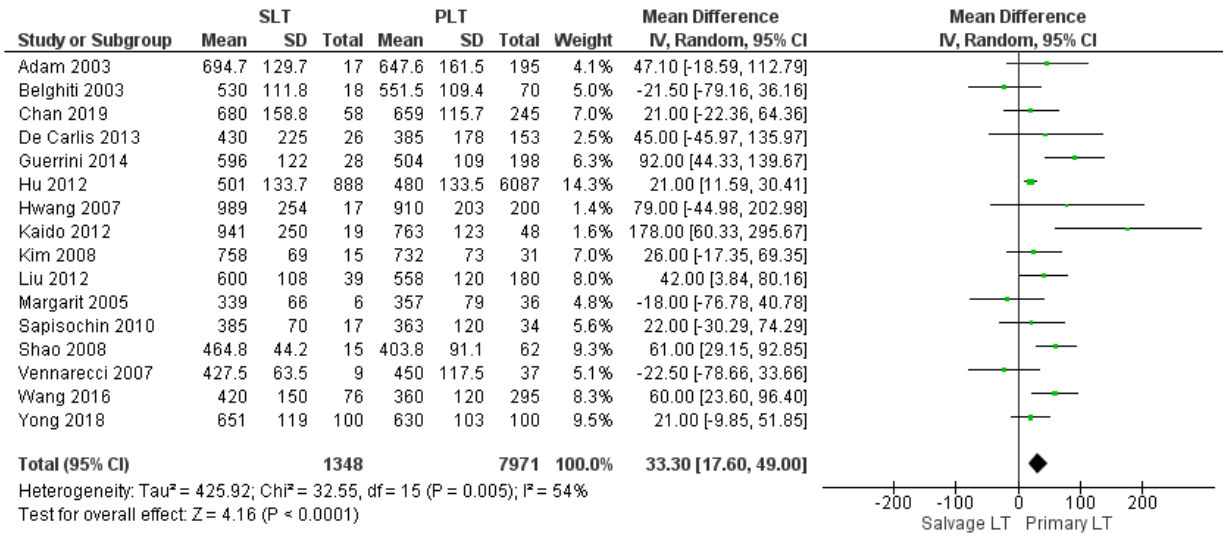
Figure 2. Operating Figure 3 - Intraoperative blood loss